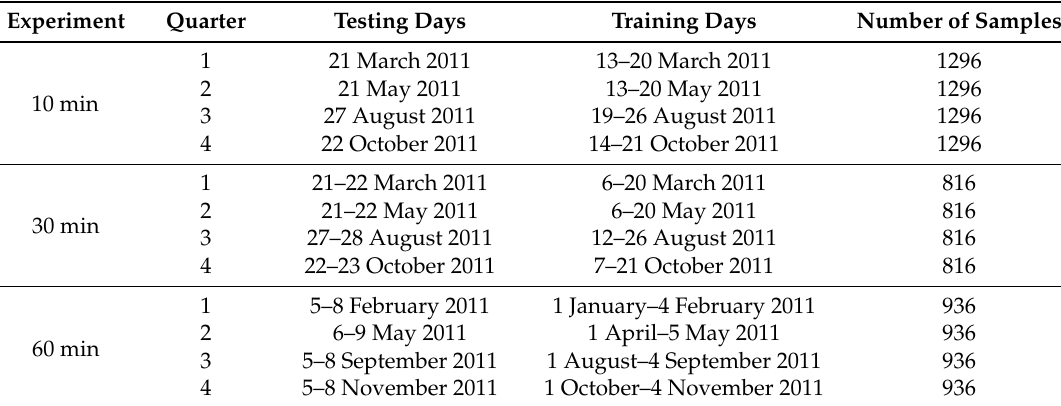
Figure 3. The location of the Peng Lai wind farm, and the data structure. Table 1. The data sets of three different